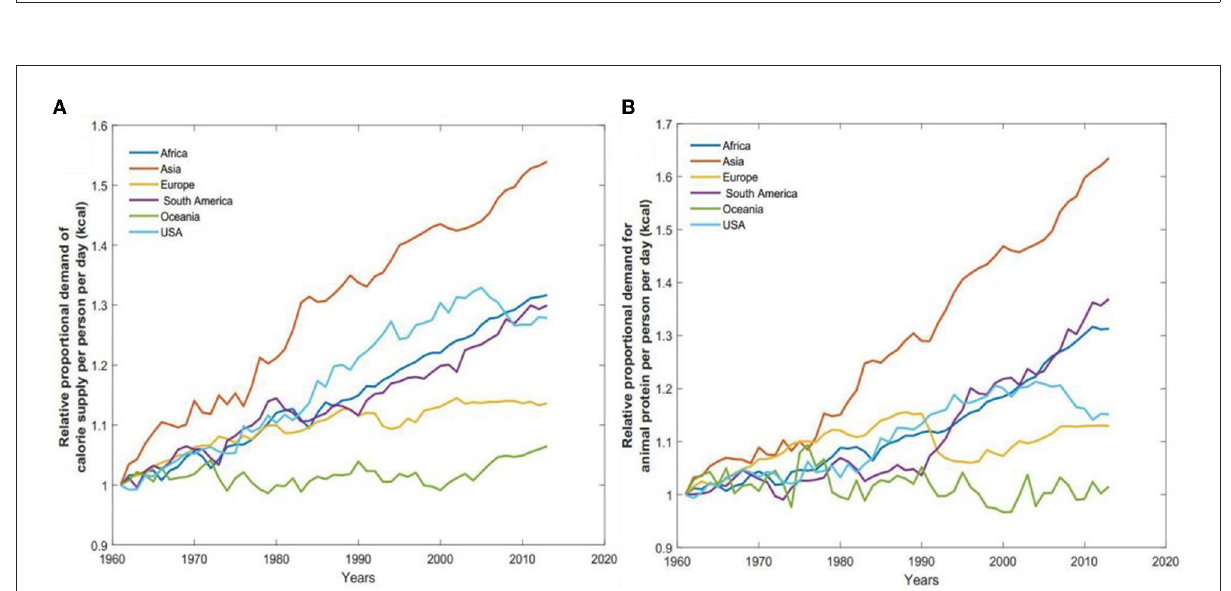
FIGURE4 Relative proportional demand in animal-based protein and calorie be capital per day. (A) Estimated daily calorie supply per capita across all regions from 1961 to 2013. (B) Daily animal protein demand in each region from 1961 to